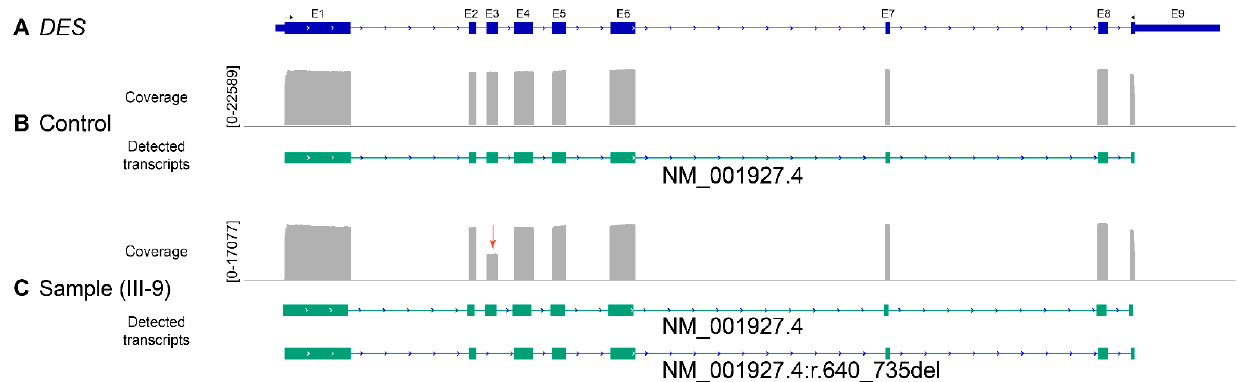
it is possible that this mutation causes a splicing defect (p.D214-E245del) and/or an amino